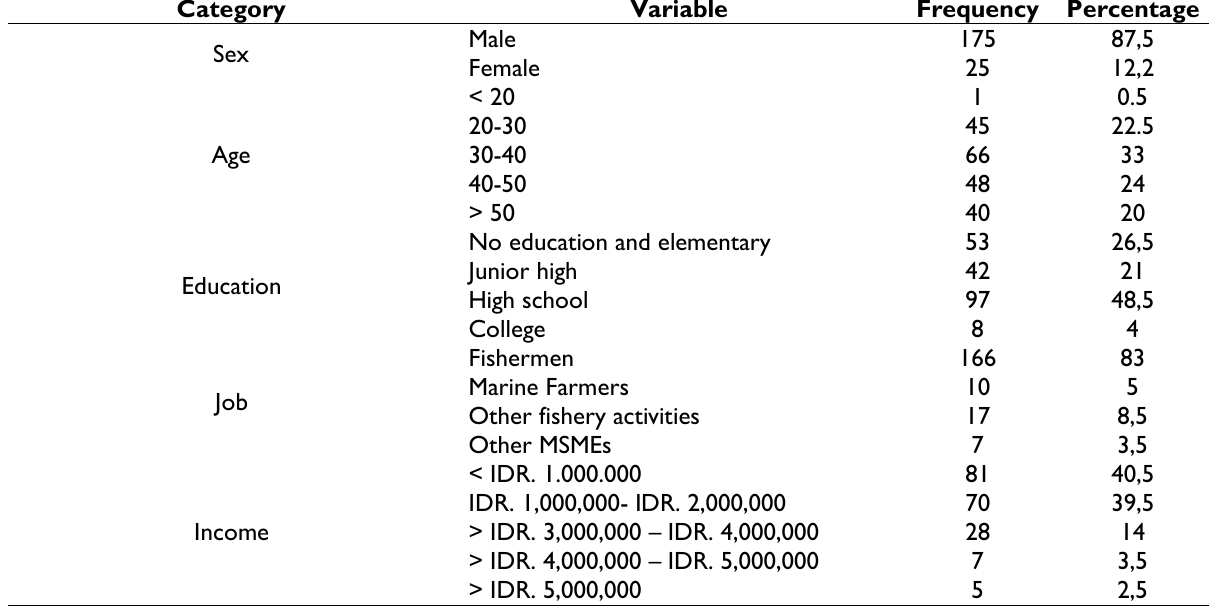
Table 2. Socio-economy